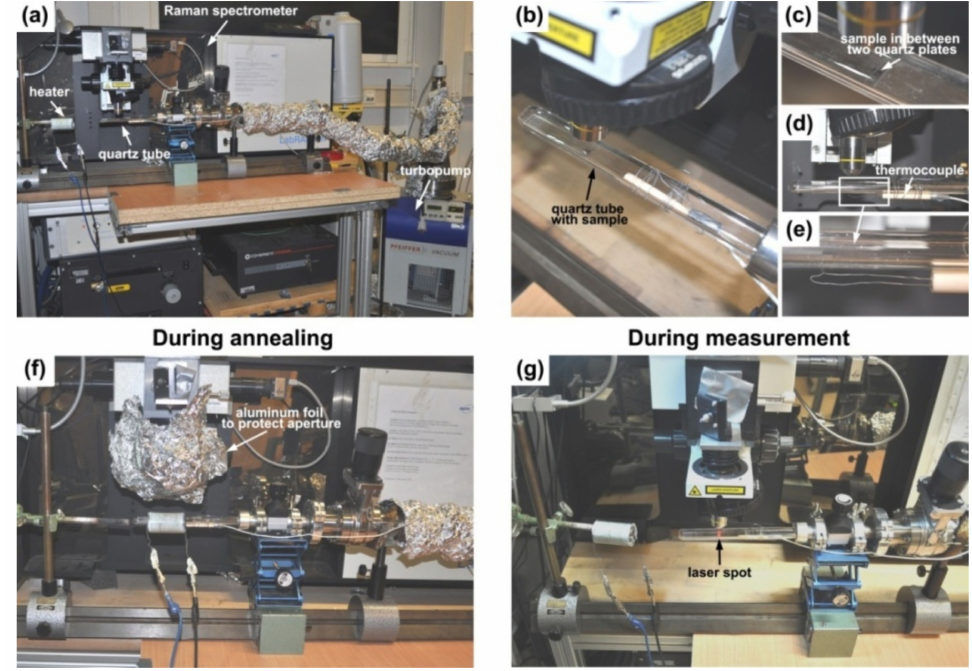
Figure 1. The setup used for in situ annealing and Raman spectroscopy measurements: ( a ) the overall view where the main parts of the setup are denoted by arrows, ( b ) the top view of the quartz tube with sample positioned under the objective of the spectrometer, ( c ) the enlarged view of the sample placed in between two quartz plates inside the quartz tube, ( d ) the side view of the quartz tube, presenting the thermocouple fixed at the bottom of the tube, ( e ) the enlarged view of the end of the thermocouple from ( d ) located below the sample, ( f ) the view of the setup during annealing, ( g ) the view of the setup during